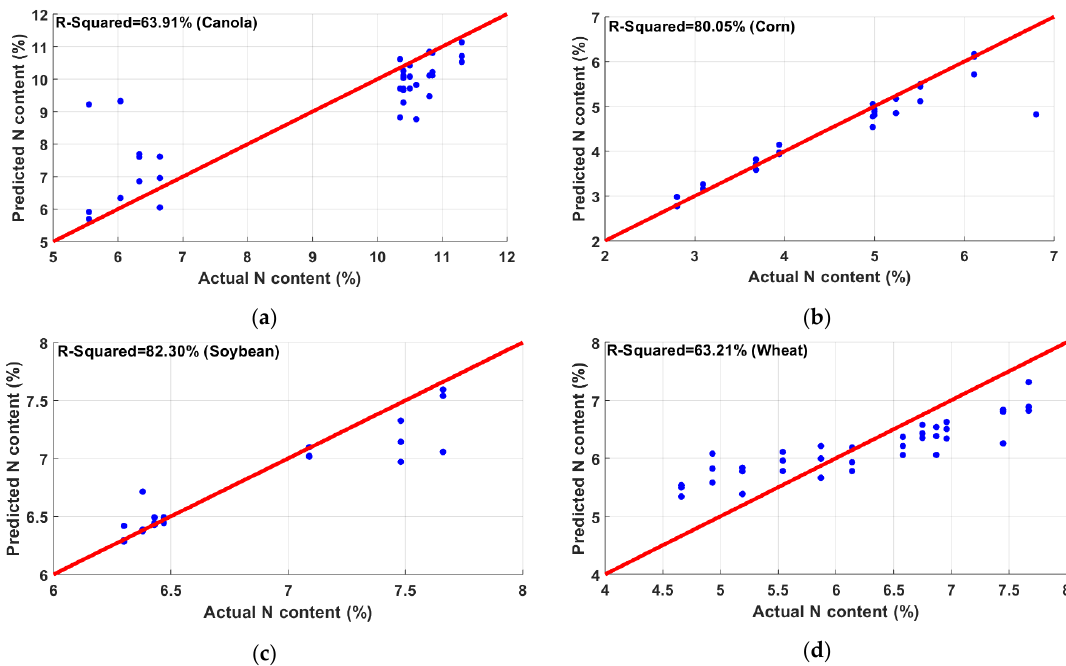
Figure 9. Correlation between the predicted N content and actual N content in ( a ) canola, ( b ) corn, ( c ) soybean, and ( d ) wheat. Soybean showed the best correlation of 82.3%, whereas wheat showed the lowest correlation (63.21%).